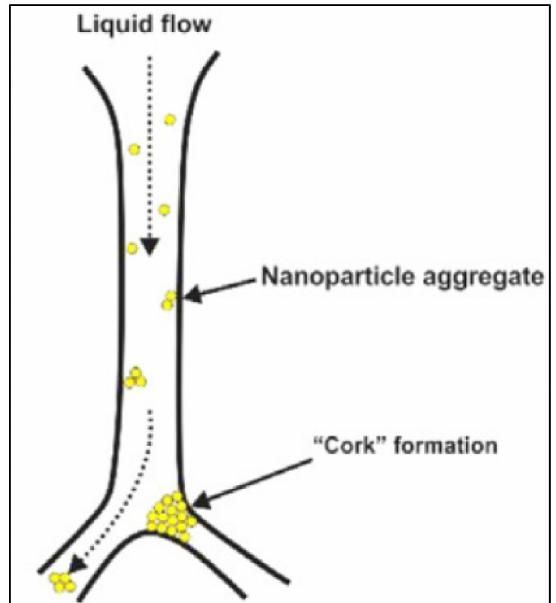
Figure 25. Cork formation: formation of nanoparticles that plugs the lamella (Adapted with permis- sion from Fei et al. [39]). Copyright 2017, The Korean Society of Industrial and Engineering Chemistry. Published by Elsevier